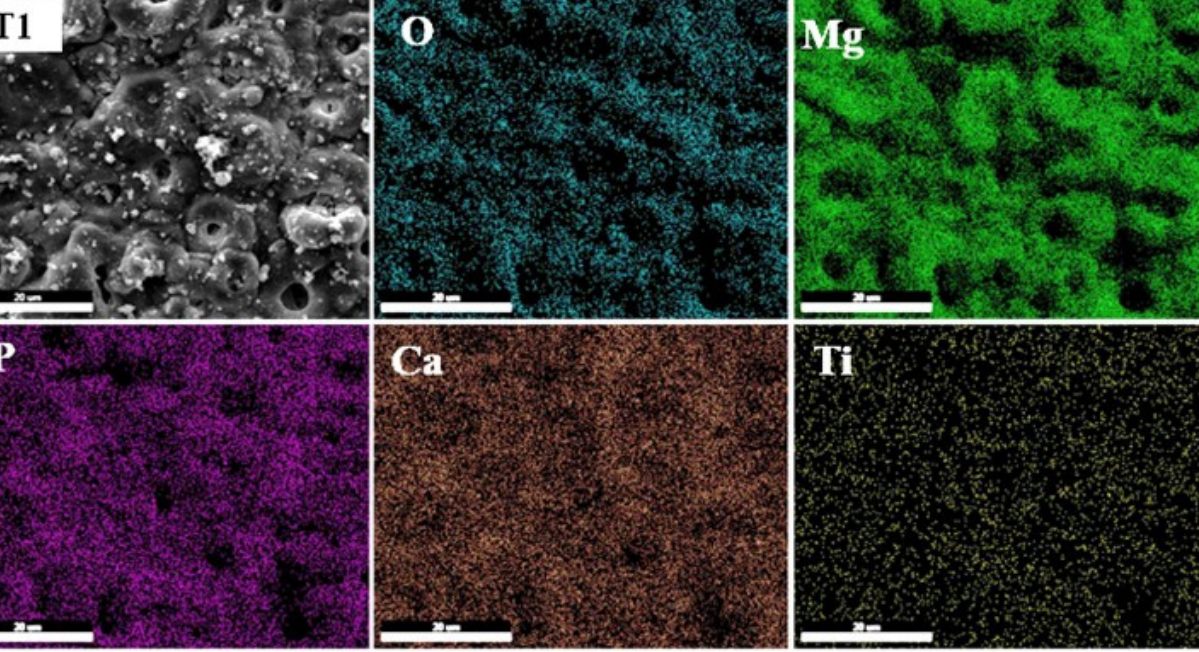
Figure 13. The surface EDS elemental mapping of samples after 72 h of immersion in SBF.